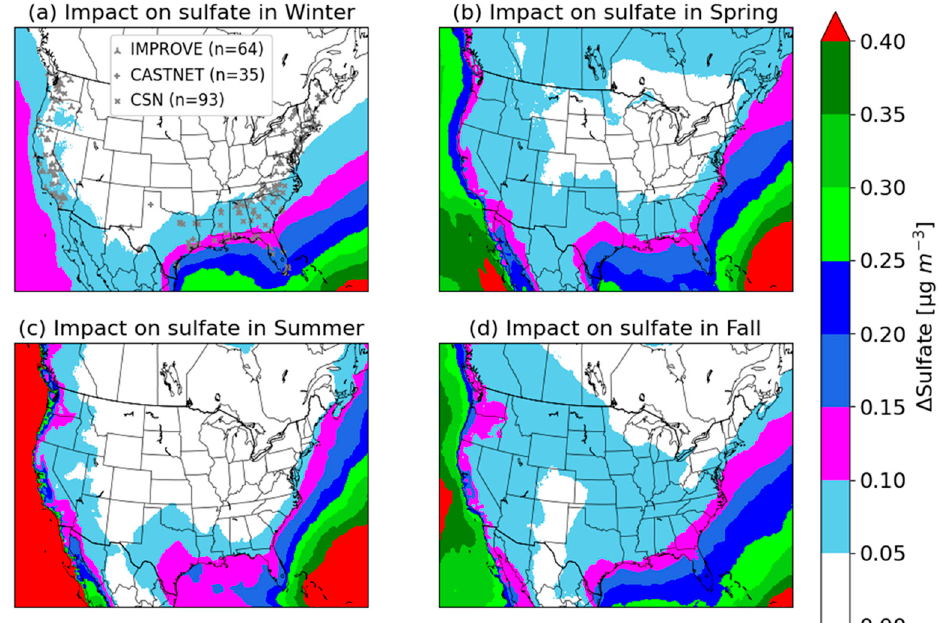
Figure 4. Spatial distribution of the seasonal impacts of DMS emissions on sulfate in ( a ) winter, ( b ) spring, ( c ) summer, and ( d ) fall. ( a ) shows monitoring locations for observed data used in Figure 8.